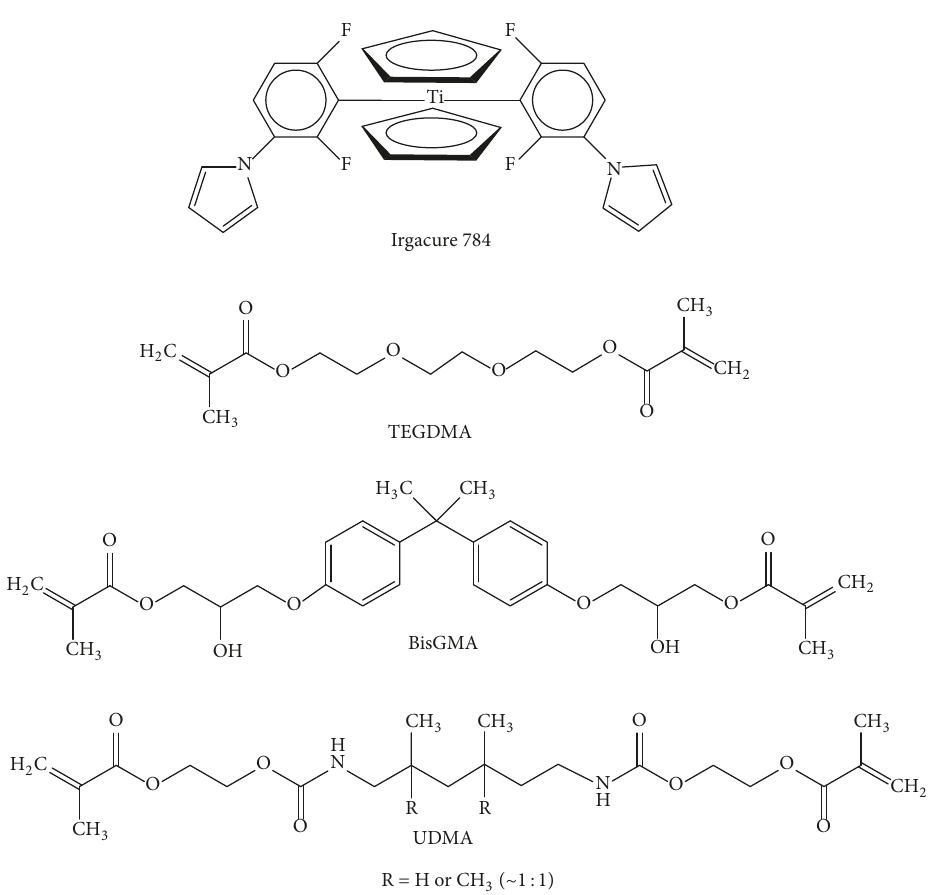
Figure 2: The chemical structure of the photoinitiator and acrylate monomers used in this study.